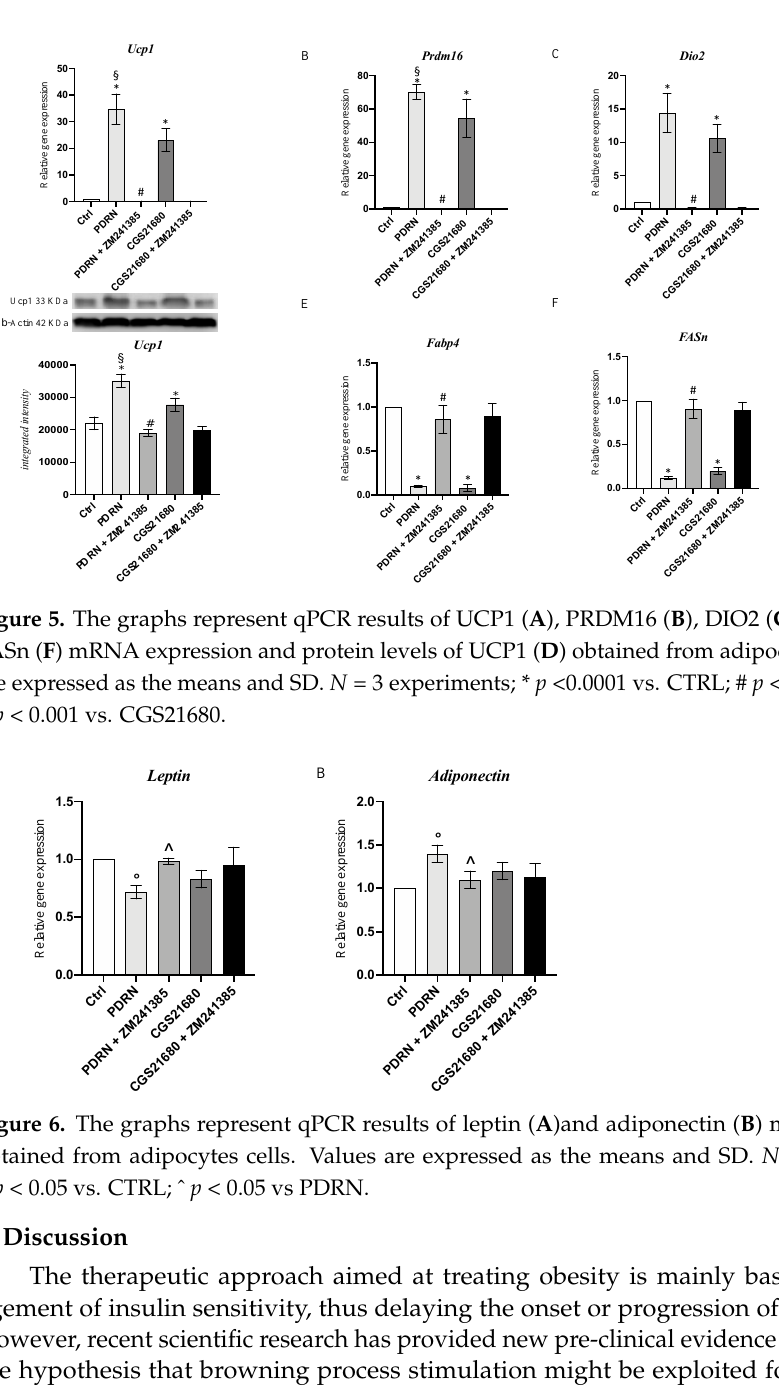
Figure 6. The graphs represent qPCR results of leptin ( A )and adiponectin ( B ) mRNA expression obtained from adipocytes cells. Values are expressed as the means and SD. N = 3 experiments; ° p < 0.05 vs. CTRL; ^ p < 0.05 vs PDRN.